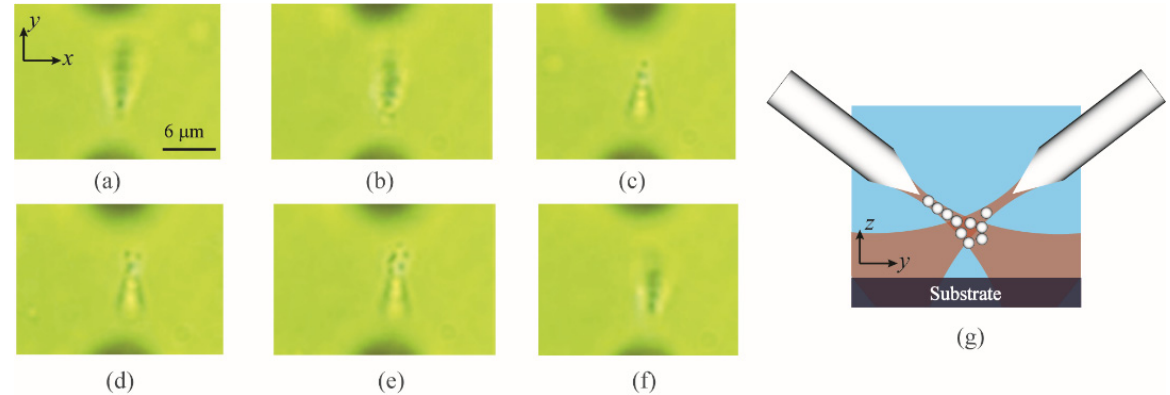
Figure 6. 3D trapping of multiple submicron particles by a dual etched fiber − based system. Multiple particles are 3D trapped in a straight line due to the optical binding effect ( a ) and ( b ). Microscope images taken when the objective lens is focused at the fiber tips ( a ) and particles ( b ). ( c ) An additional group of particles trapped close to the upper fiber. The number of particles in the group is increased ( d ) and ( e ). ( f ) No influence of the increased number of the cluster particle on the trapped particles due to the optical binding effect. The bright − field images taken through an oil immersion 100 × objective lens. ( g ) The schematic for trapping multiple submicron particles in three dimensions by a dual − fiber − taper − based trapping system.